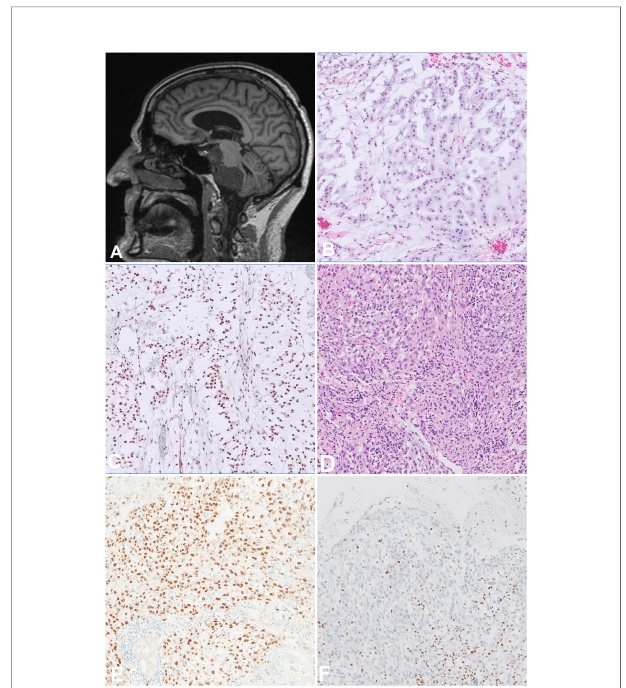
FIGURE 3 | Chordoma. (A) Sagittal MRI scan showing a destructive tumour arising in the skull base and extending to the adjacent structures. (B, C) Conventional chordoma composed of atypical epithelioid cells arranged in chords and set in abundant myxoid matrix with a light basophilic appearance, the cells are positive for Brachyury. (D, E) Poorly differentiated chordoma composed of atypical epithelioid cells with a rhabdoid morphology and set in a more fi brous stroma, the cells are positive for Brachyury. (F) The tumour cells show lost expression of INI1, as opposed to background lymphocytes which can be used as positive control.